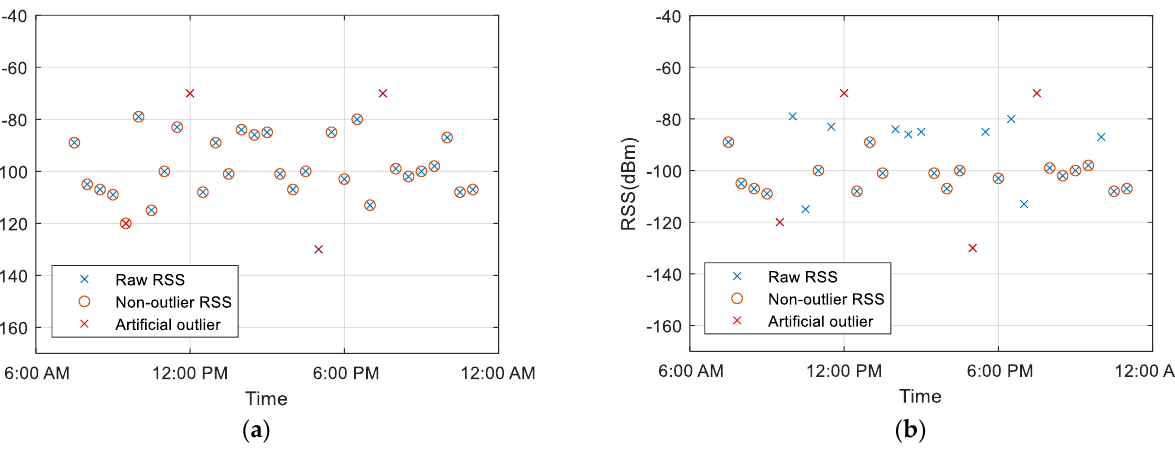
Figure 14. Outlier detection comparison of RSS Dataset 4 with and without artificial outliers for: ( a ) 𝑆 𝑛 scale estimator ( b ) MAD scale estimator. Table 3. RSS observation representative